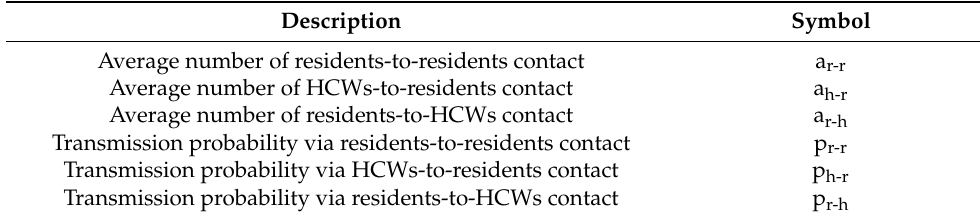
Table 4. The six parameters used in the three transmission rates.